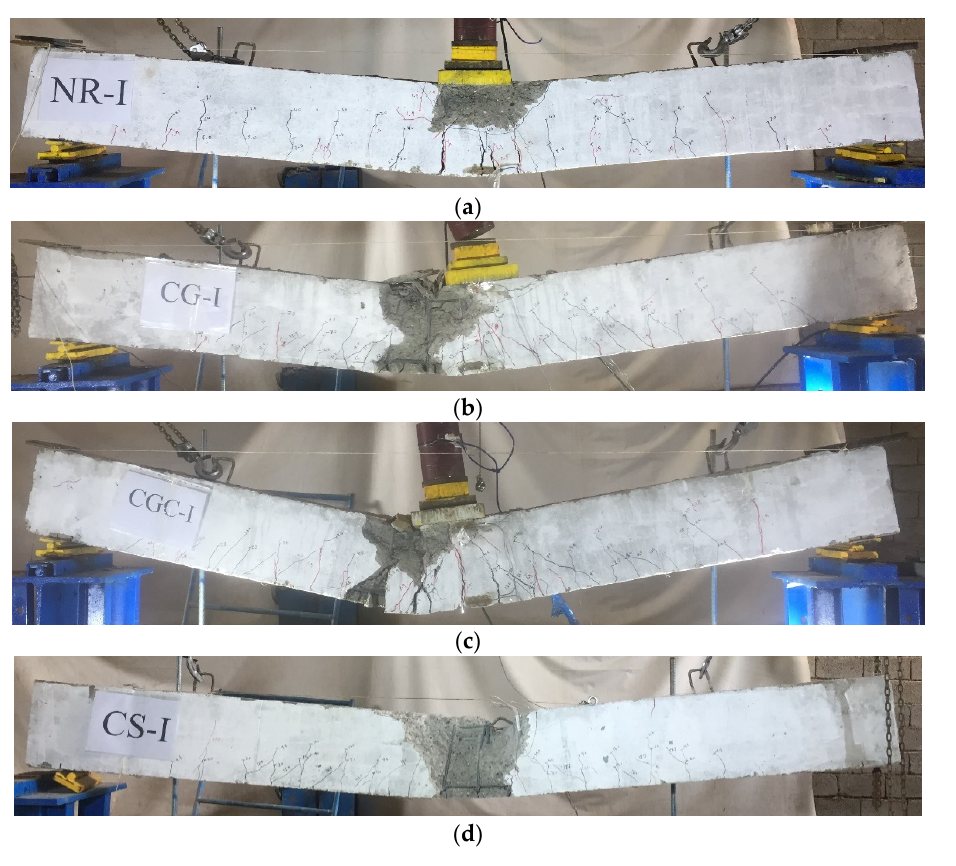
Figure 11. Crack patterns for impact specimens after the residual static tests: ( a ) Specimen NR ‐ I; ( b ) Specimen CG ‐ I; ( c ) Specimen CGC ‐ I; ( d ) Specimen CS ‐ I.